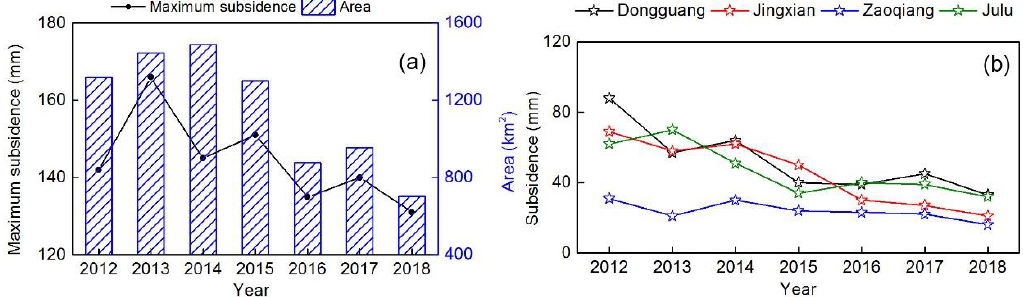
Figure 9. ( a ) Time-series subsidence change and area of subsidence greater than 50 mm from 2012 to 2018 in the typical Baoding, Hengshui, Cangzhou and Xinngtai regions. ( b ) The annual land subsidence changes from 2012 to 2018 for four subsidence features.